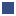
Influence of increasing concentrations of extracted EPS on zeta potential (■) and size (■) of bare (A), amine-functionalised (B), carboxylate-functionalised (C) and aromatic-functionalised (D) silica NPs.